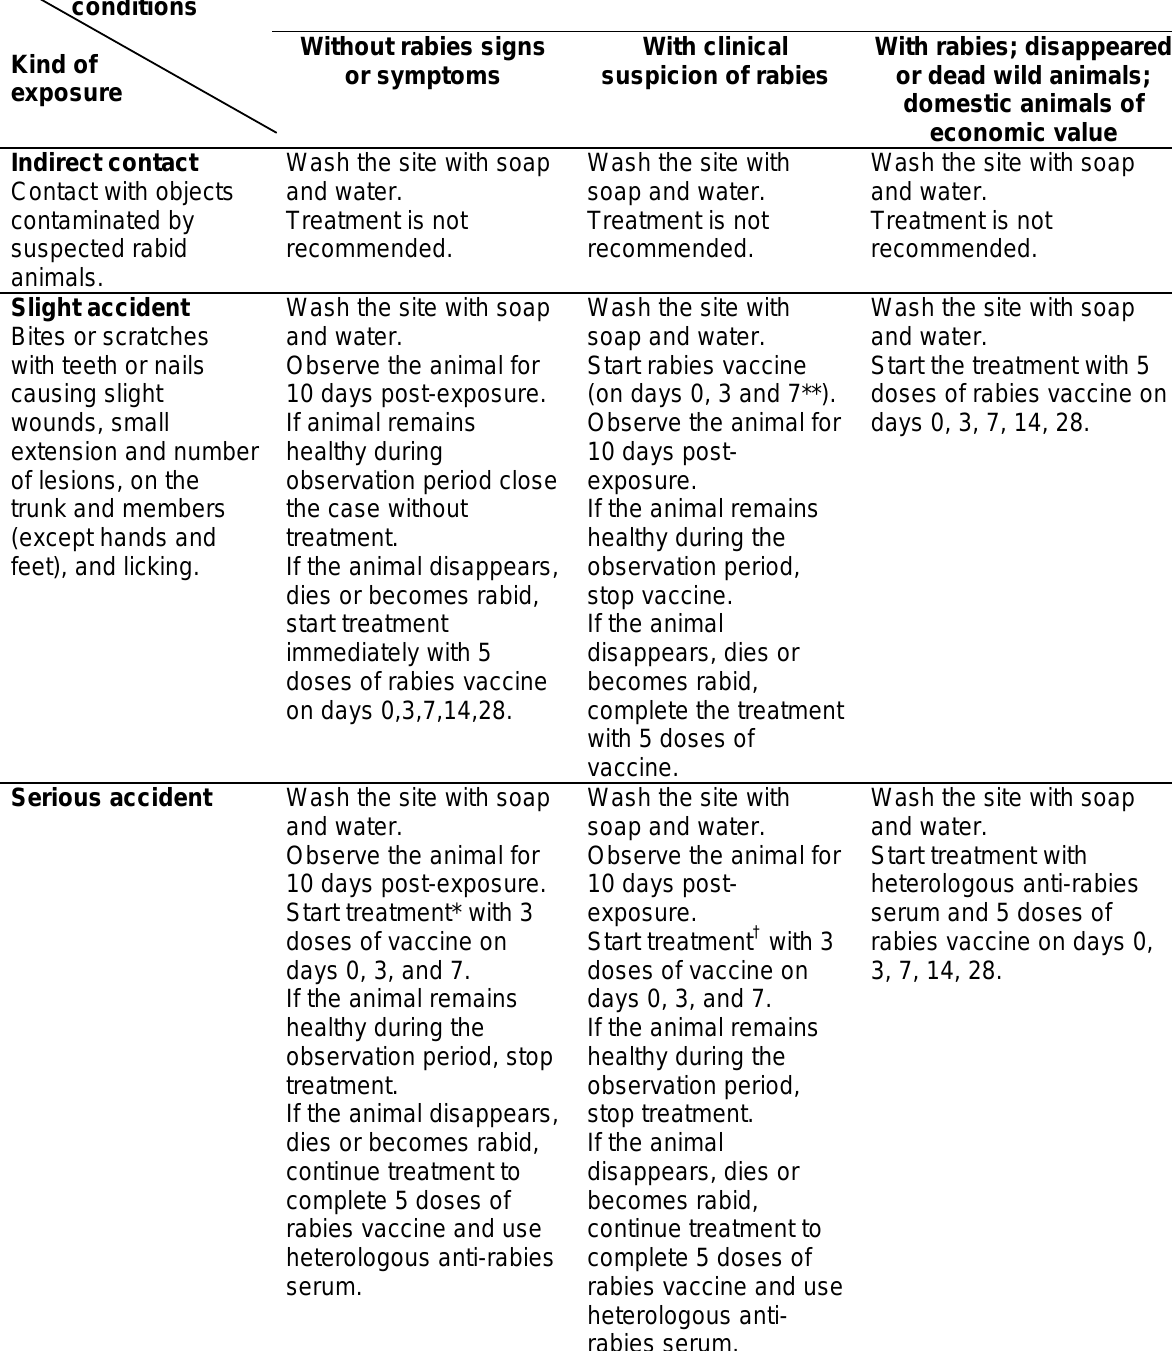
Table 5: Post-exposure rabies